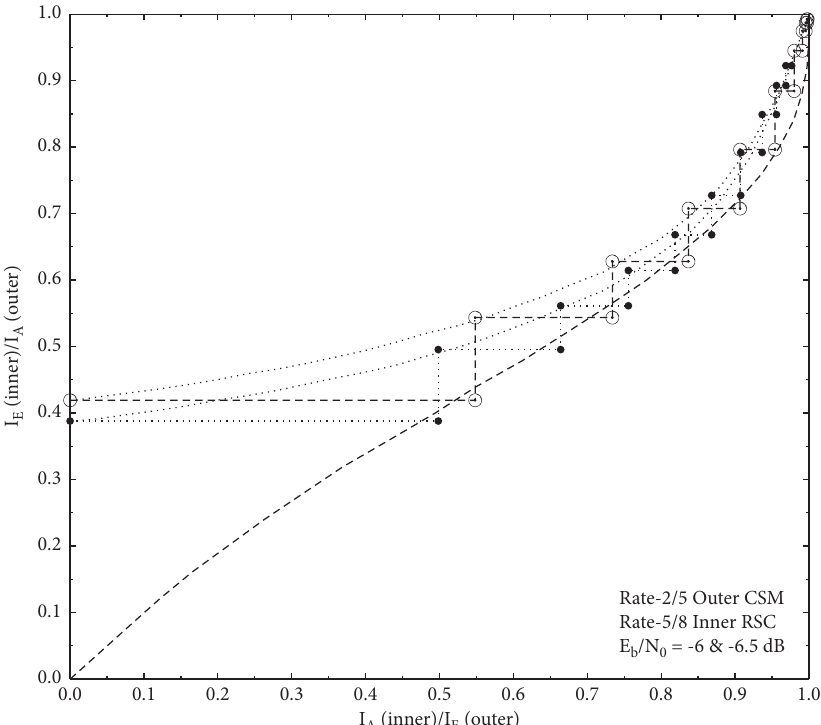
Figure 9: EXIT chart curves and decoding trajectories for Rate-4/10 CSM ( Mapping-II ) scheme.